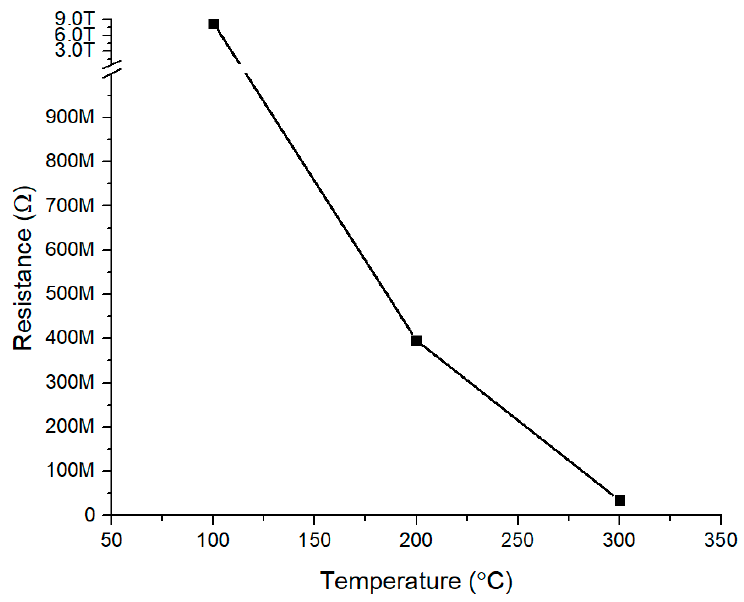
Figure 9. Electrical Characteristics of TiO 2 -B 2 O 3 at different operating temperature.